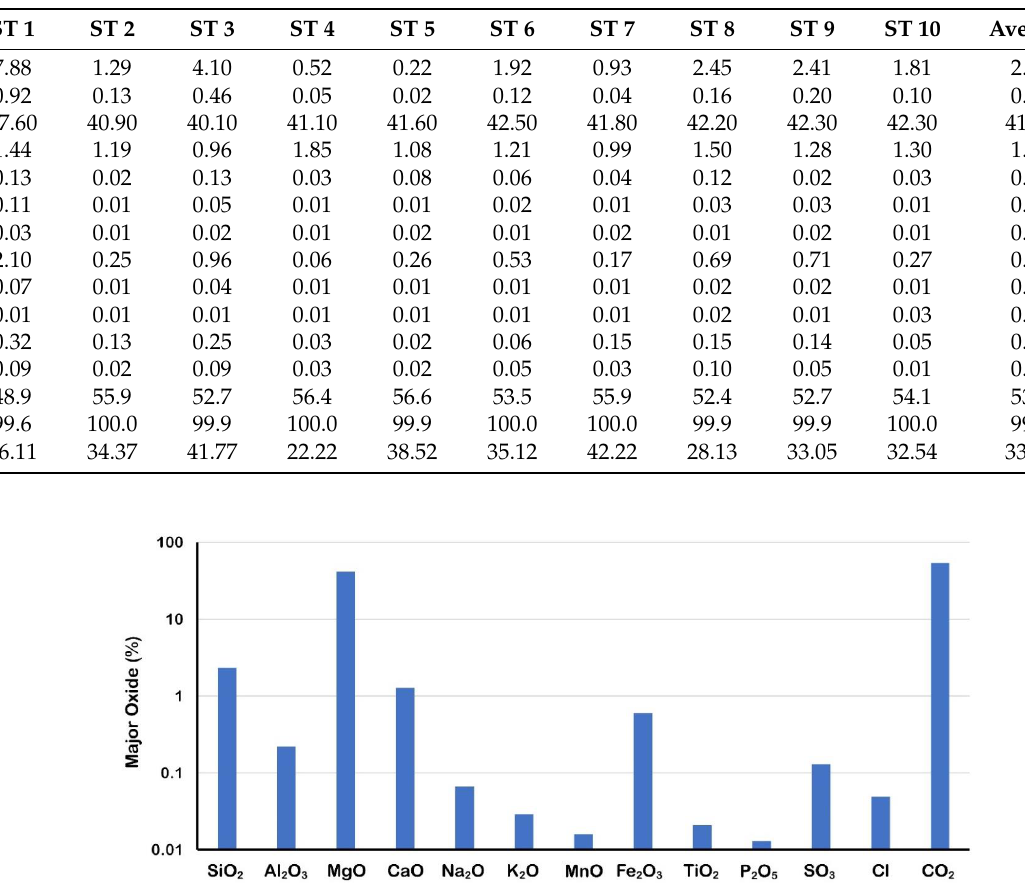
Figure 4. Major oxide contents (%) of the stromatolite samples from Lake Salda.